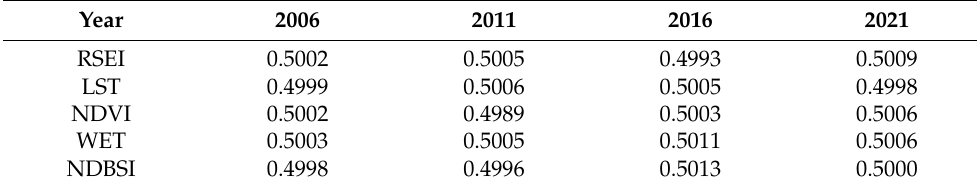
Table 8. The mean value of RSEI of the different years.